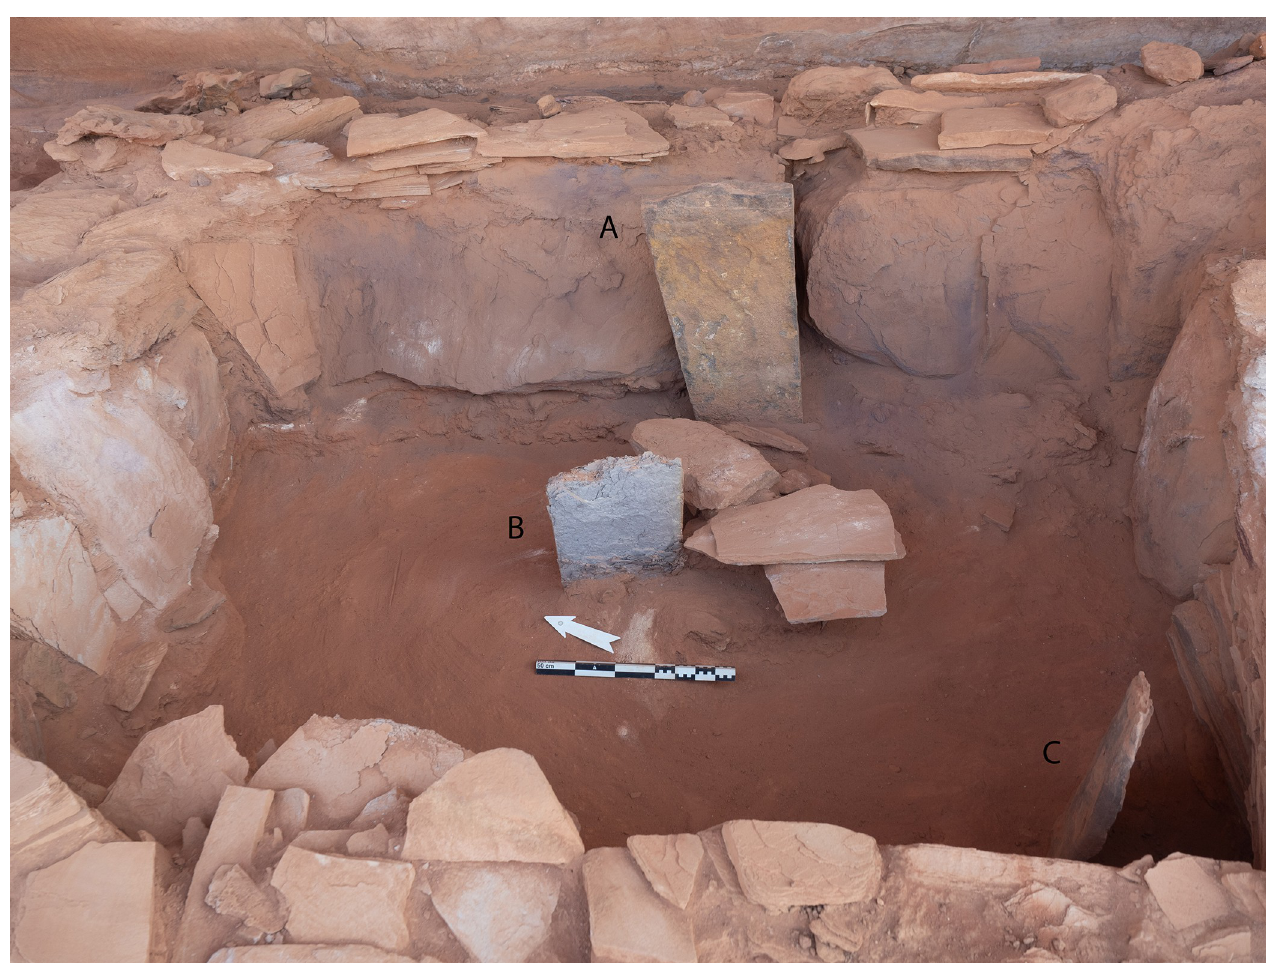
Fig 7. The main (central) chamber of mustatil IDIHA-F-0011081 with three up-right stones (A-C). Flat stones in centre of image acted as support for primary up-right stone in the rear. The blocked doorway is visible in the left of the photo.